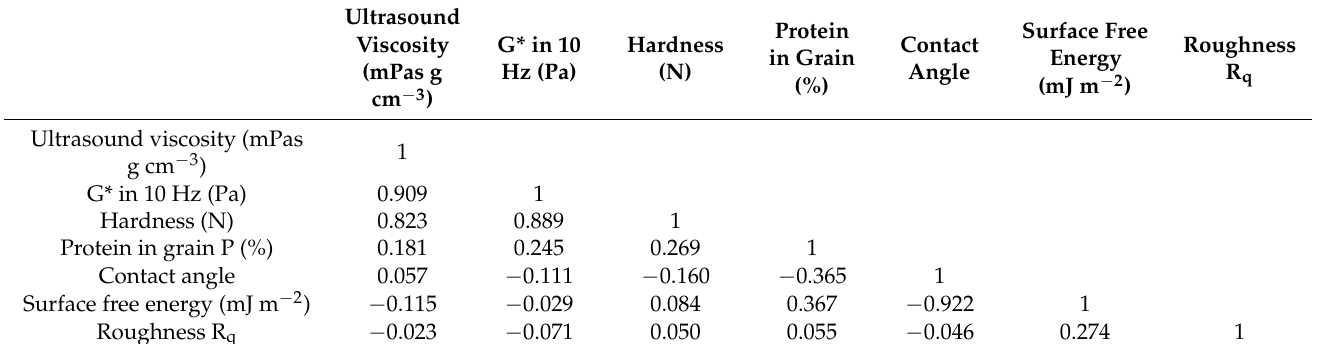
Table 10. Correlation coefficients between measured physicochemical properties of gluten and content of protein in the